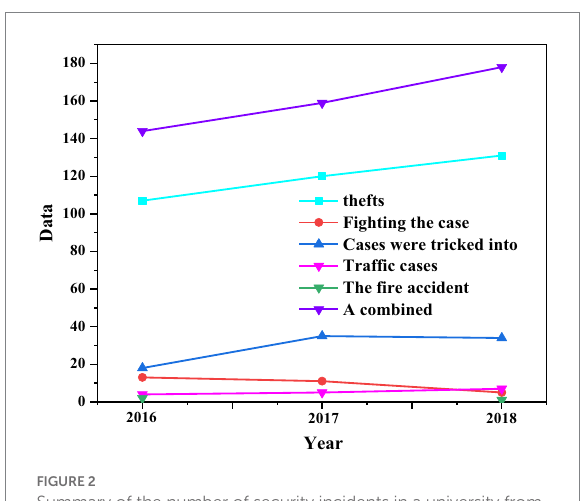
FIGURE 2 Summary of the number of security incidents in a university from 2016 to